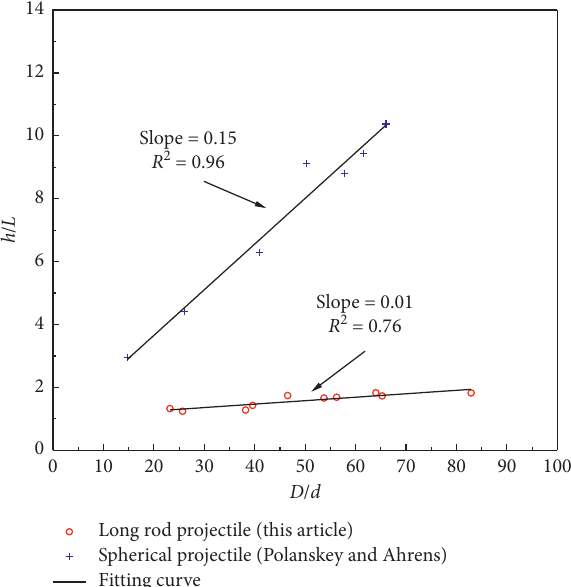
Figure 9: Relation between the dimensionless diameter and the dimensionless depth.